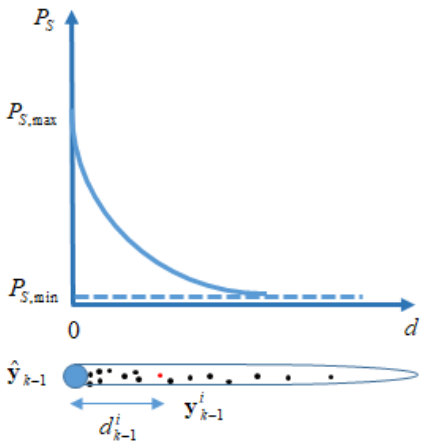
Figure 1. The adaptive survival